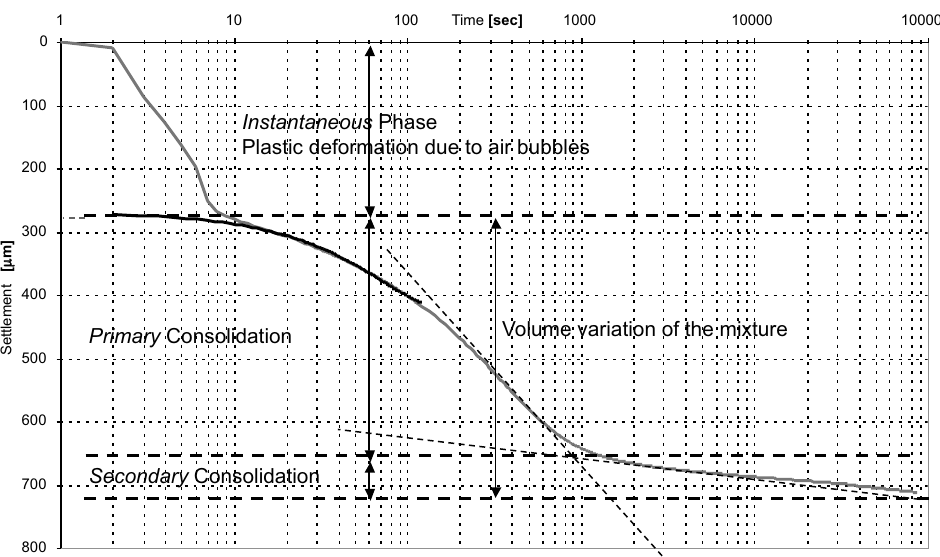
Fig. 5 – Typical record of settlement versus Log ( t ) for a single loading stage, separated into three mechanisms decoupled in